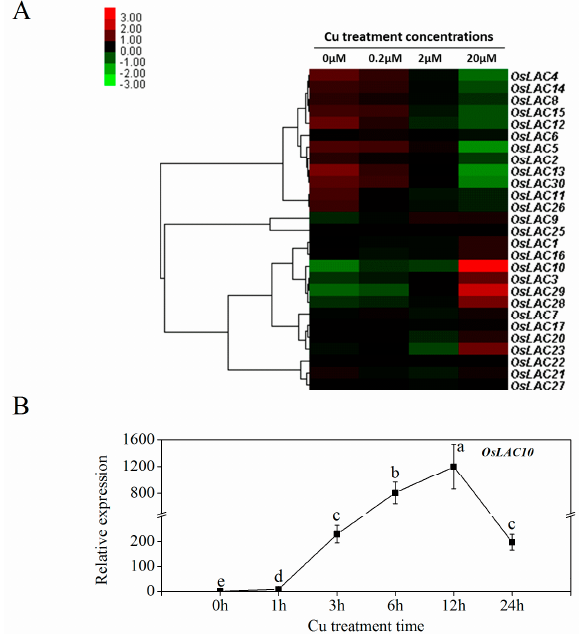
Figure 5. Expression of OsLAC10 in rice roots under Cu stress. ( A ) Cluster heat map of rice laccase genes expressions under various Cu treatments; ( B ) qPCR analysis of the time course of OsLAC10 expression in Cu (20 µ M)-treated rice roots. The data are the means ± SD ( n = 3). Data were ln(x + 1) transformed to achieve homogeneous variances before statistical analysis, different letters (a, b, c, d, e) above the column indicate a significant difference at p < 0.05 according to the least-significant difference (LSD)